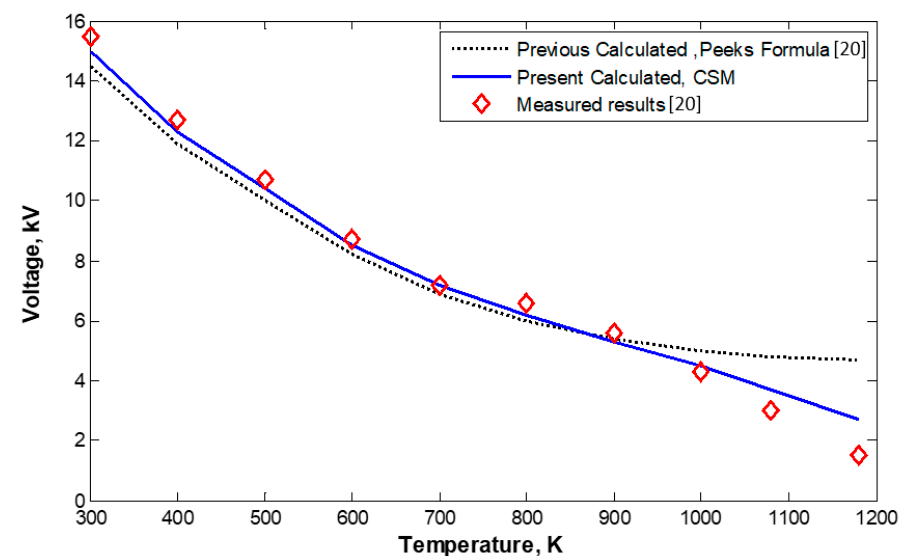
Figure 13. A comparison between the results of CSM and Peek’s Formula [20] in calculating the corona-onset voltage of single-wire WDESP with a high temperature.